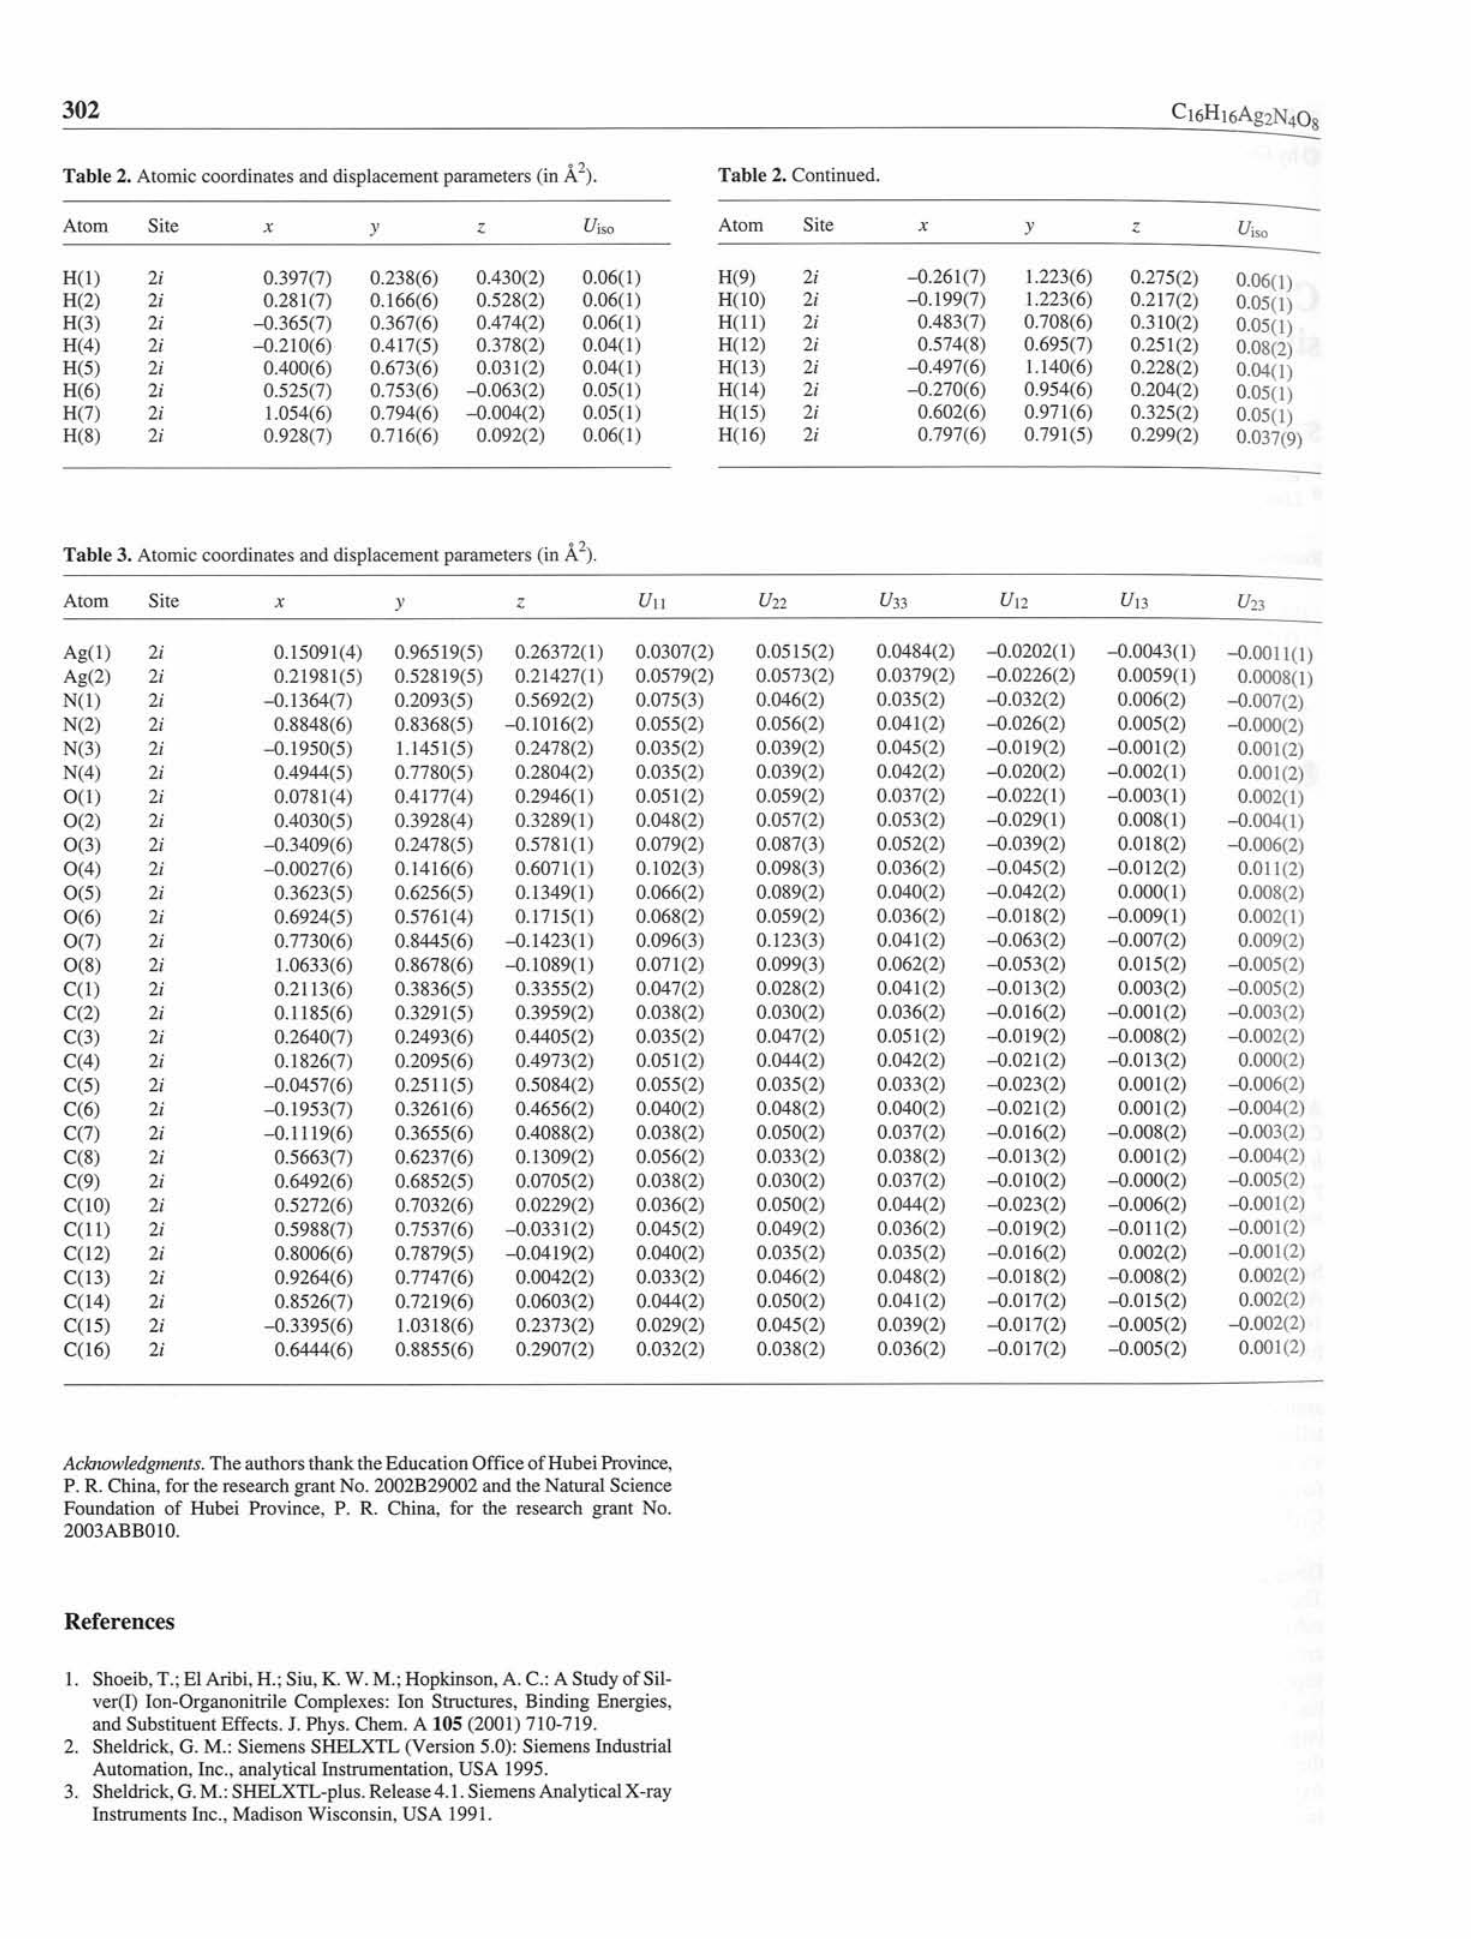
Table 2. Atomic coordinates and displacement parameters (in Á 2 ). Table 2. Continued.